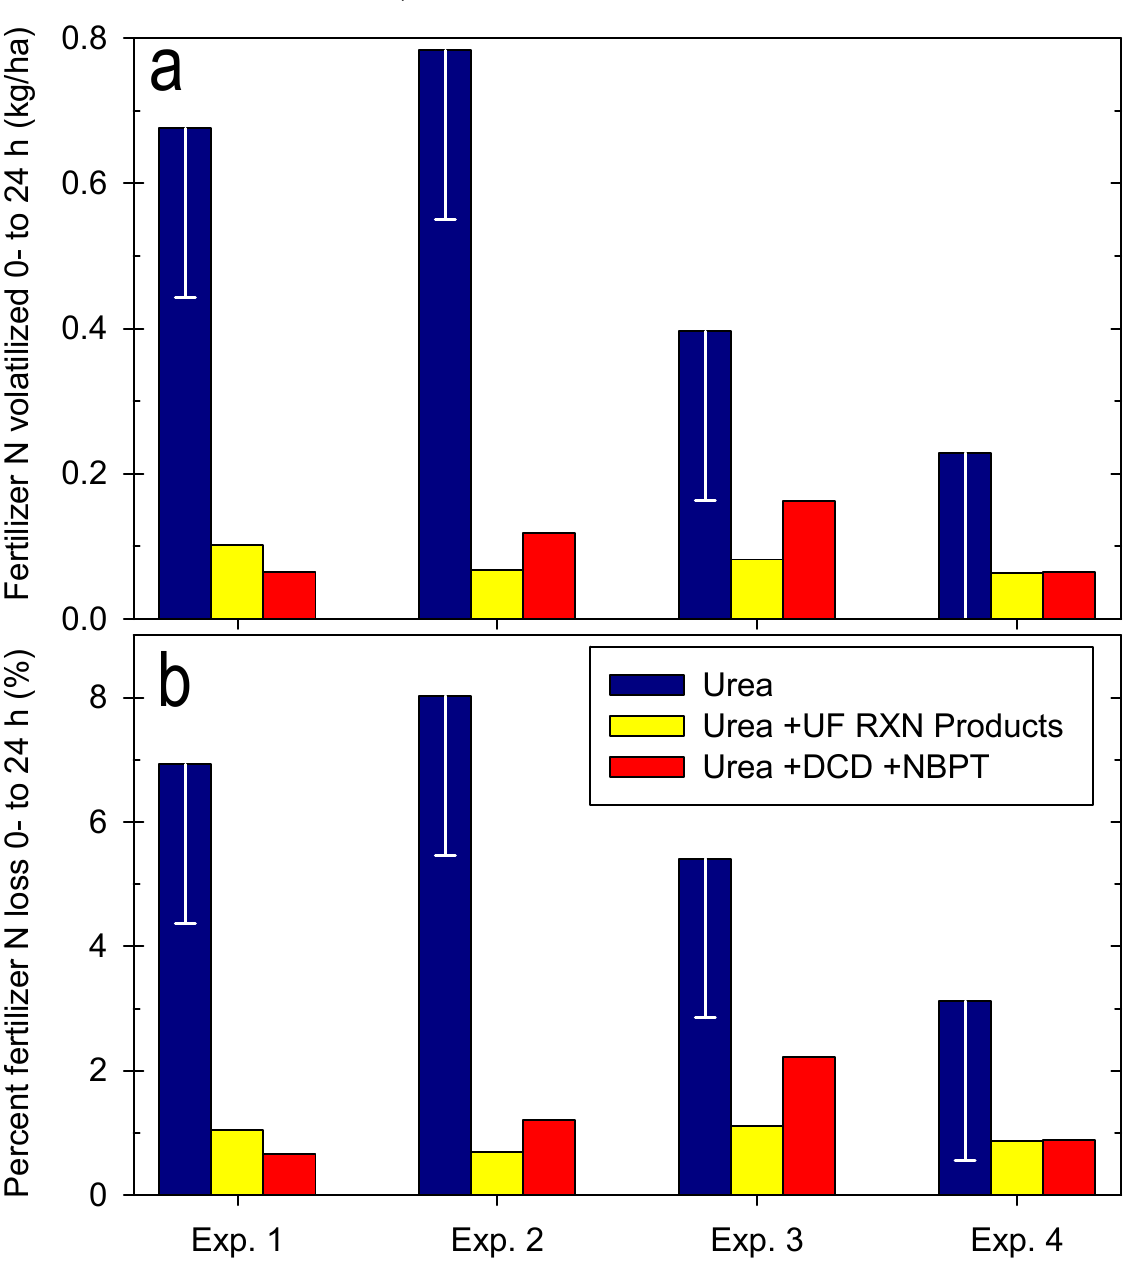
Figure 2. Comparisons of fertilizer N volatilized in mass per unit area ( a ) or percent fertilizer loss as NH 3 -N ( b ) by fertilizer source and experiment. Means overlapping error bar are not significantly different from conventional urea at a 5% alpha level.